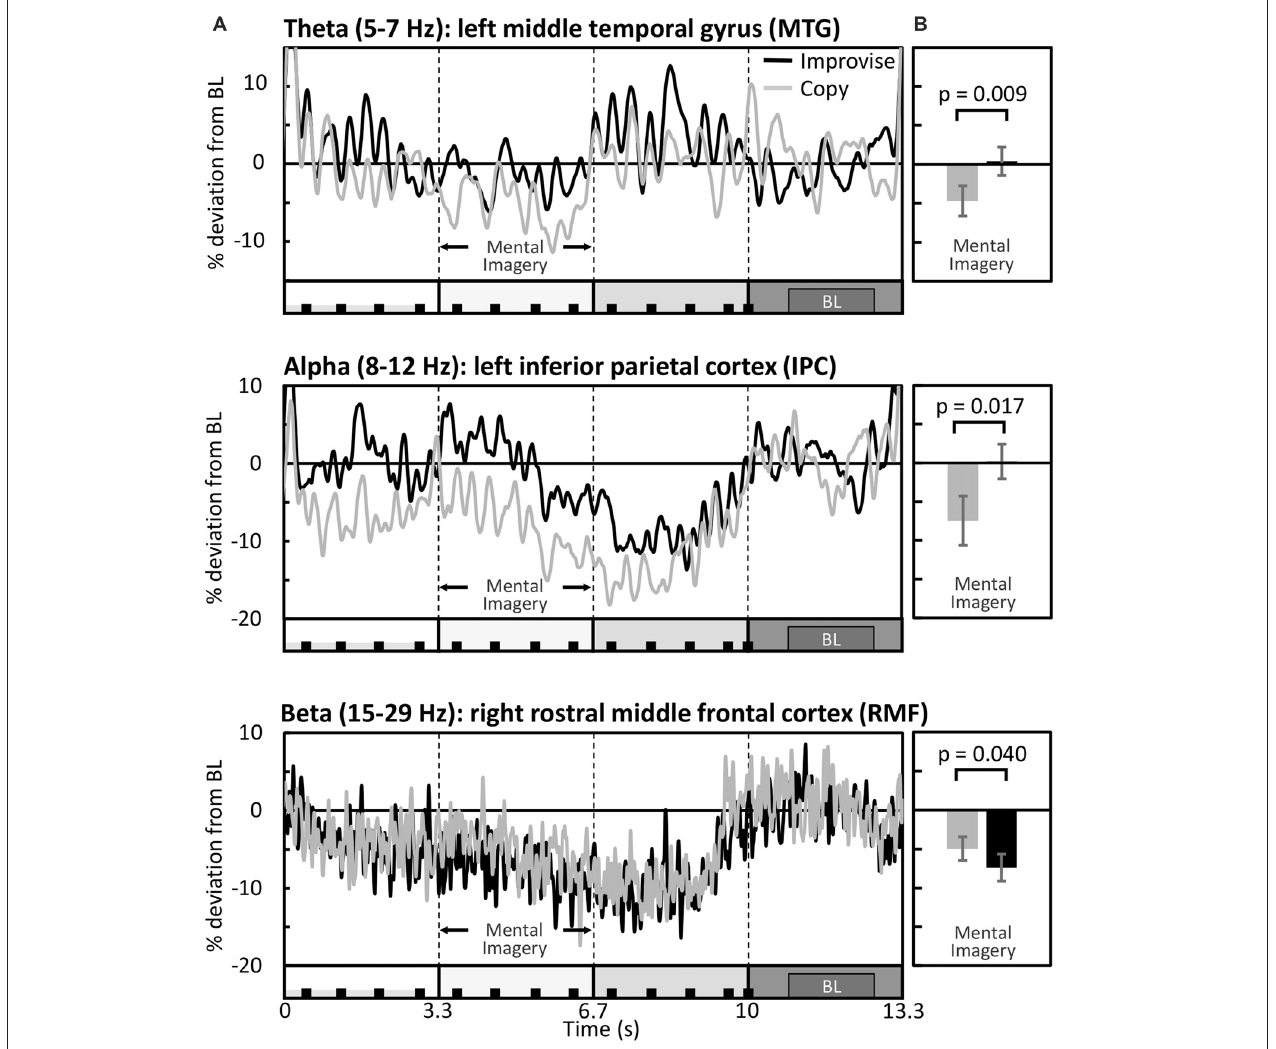
FIGURE 4 | Differential modulation of spectral activity during the Multi-finger task. (A) Mean brain activity across the entire stimulus-response epoch in representative brain areas ( N = 13). The X axis is represented by a minimalized version of the stimulus-response epoch diagram which is detailed in Figure 1 . BL denotes the baseline period. (B) Respective mean activity over the mental imagery